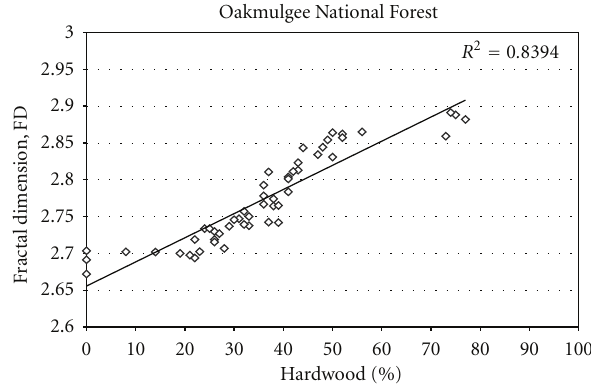
Figure 18: Moran’s I versus saplings (bounds excluded).